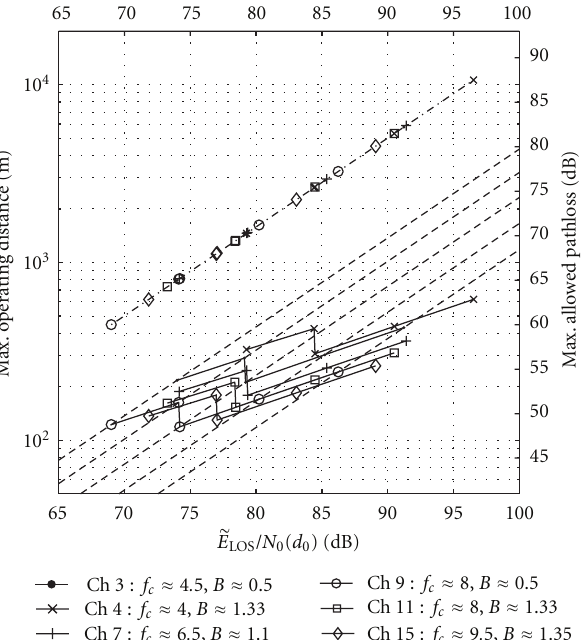
Figure 9: Maximal operating distance and maximal allowed pathloss for the specific IEEE 802.15.4a channels. The dashed lines show the characteristic for a channel with B = 499 . 2MHz with the ND of Figure